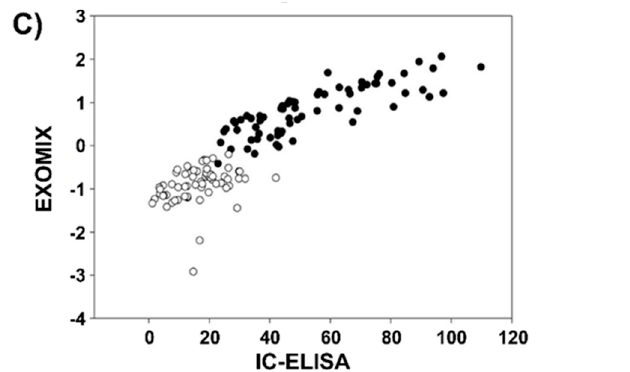
Figure 3. Nanoscale flow-cytometry (NSFC) / IC-ELISA original plane ( A ) together with the relations between the combined score (EXOMIX) with the exosome biomarkers ( B , C ). Table 1. ROC Analysis of Different Methods.